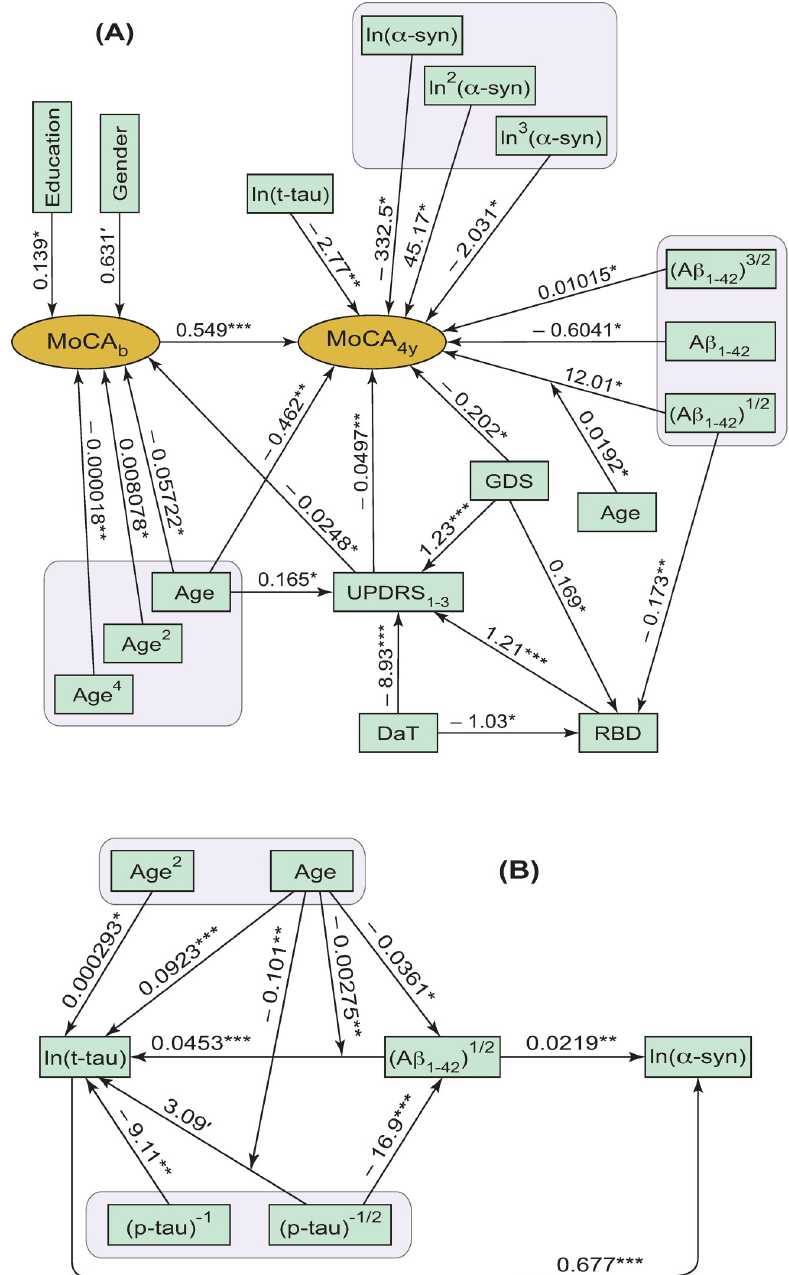
Fig 1. GSEM networks of significant ( p < 0.1) direct and indirect effects for the fourteen baseline variables, MoCA b and MoCA 4y . (A) The network of effects on the MoCA scores at baseline and 4 years later; and (B) the additional network of effects between the CSF parameters and baseline age, with p-tau as the primary independent protein variable. The arrows between the variables show the directions of the direct effects. The arrows pointing to other arrows indicate the significant interaction effects. The asterisks indicate the levels of statistical significance of the respective regression coefficients: ( ��� ) p < 0.001; ( �� ) 0.001 � p < 0.01; ( � ) 0.01 � p < 0.05; ( 0 ) 0.05 � p < 0.1.